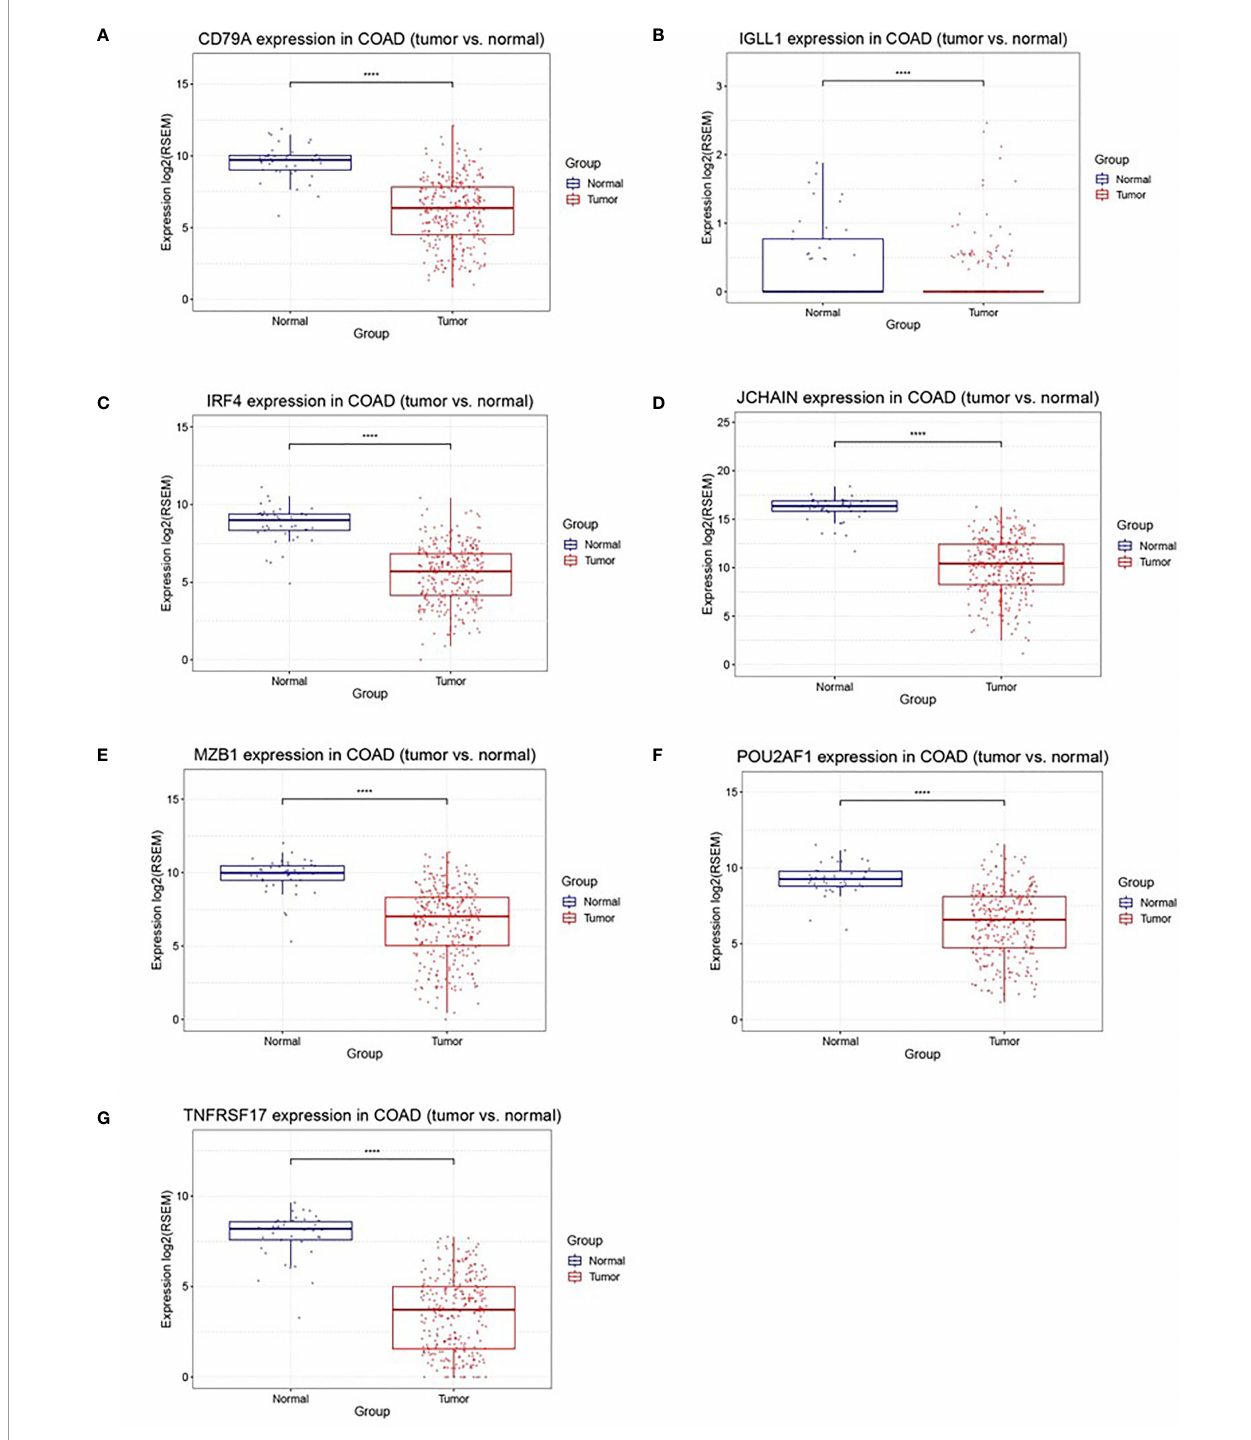
FIGURE 6 | Differently expression of 7 hub genes between cancer tissues and normal tissues in colon cancer. (A – G) were CD79A, IGLL1, IRF4, JCHAIN (IGJ), MZB1, POU2AF1, TNFRSF17, respectively, ****P < 0.001.